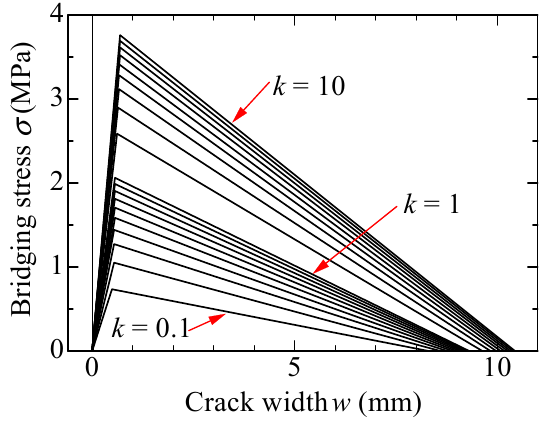
Figure 5. Modeled bridging law.